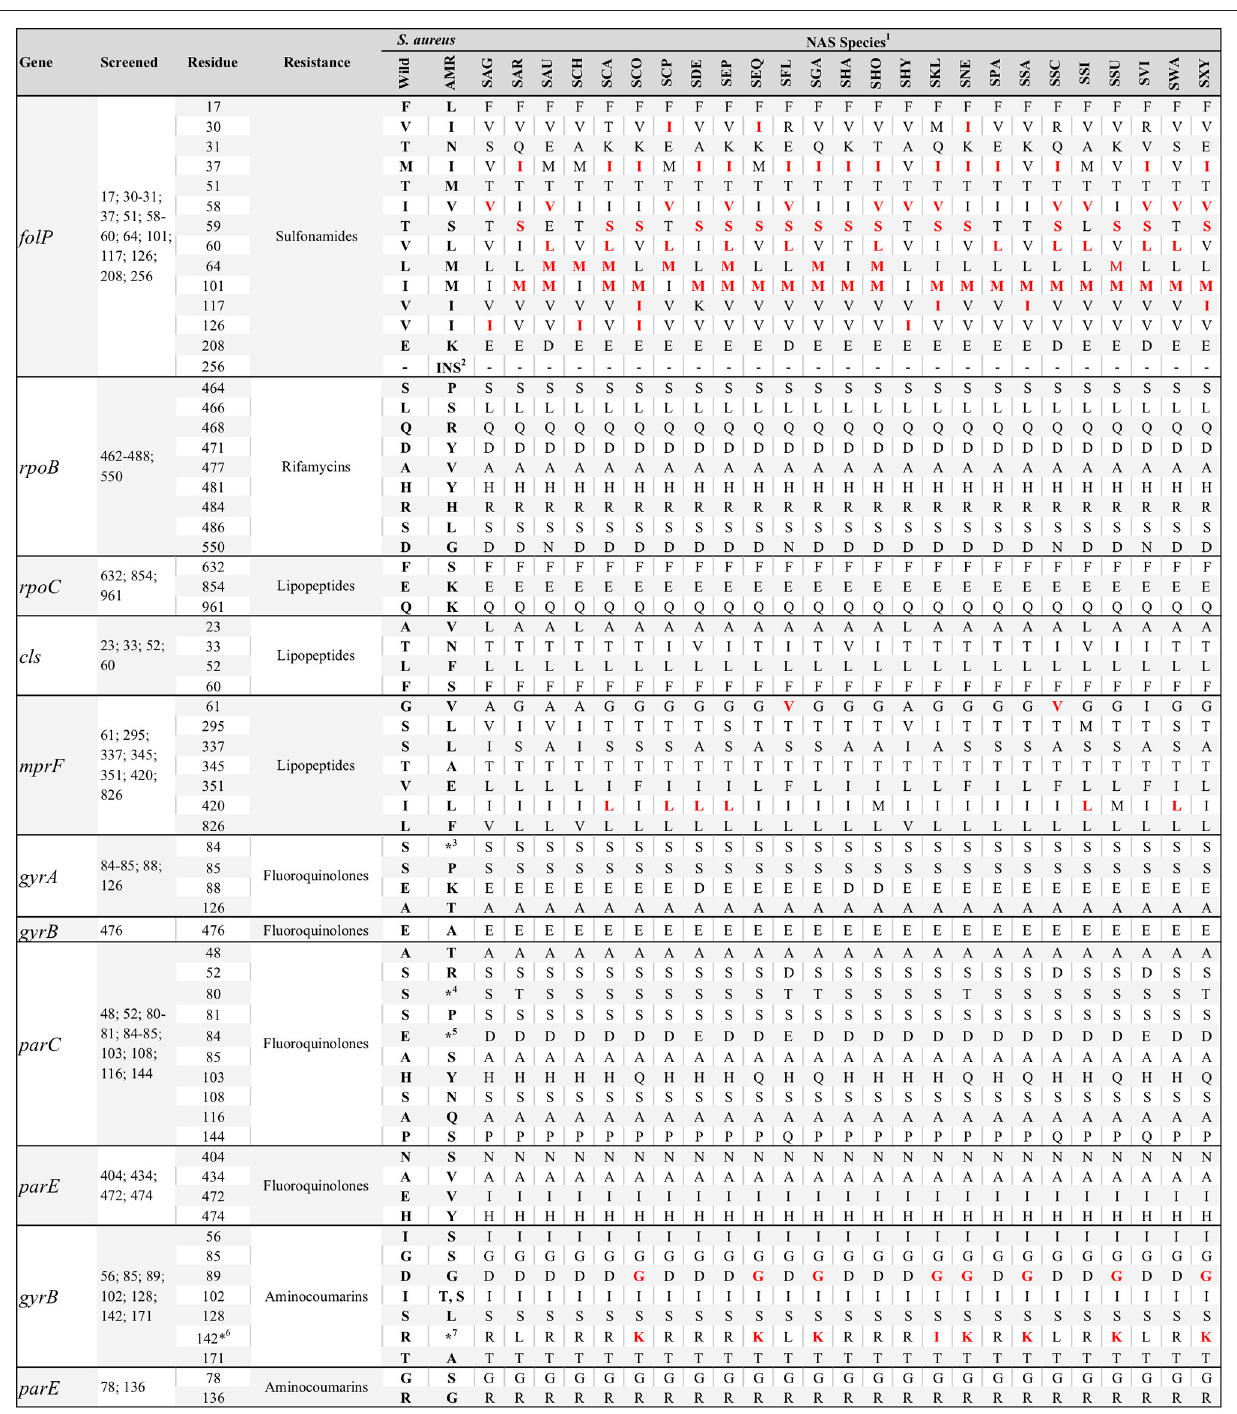
Frontiers in Microbiology |